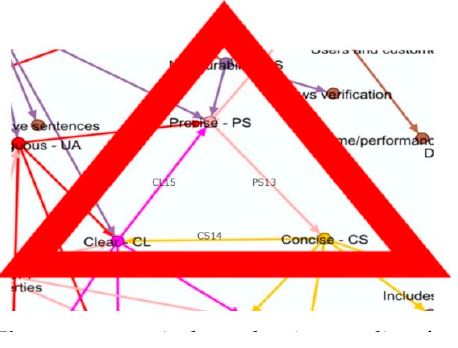
Figure 3. semantic dependencies—cyclic references. Figure 3. Semantic dependencies—cyclic